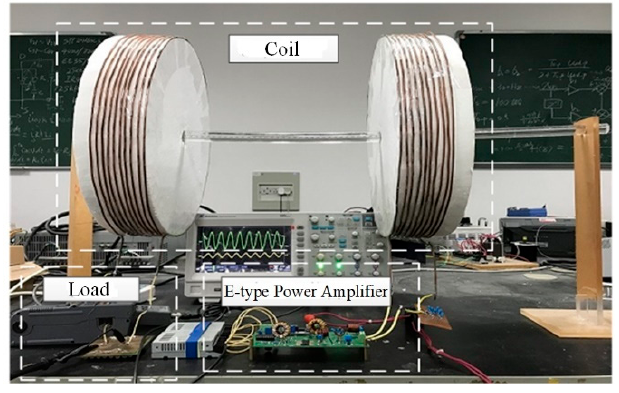
Figure 6. Experimental platform.